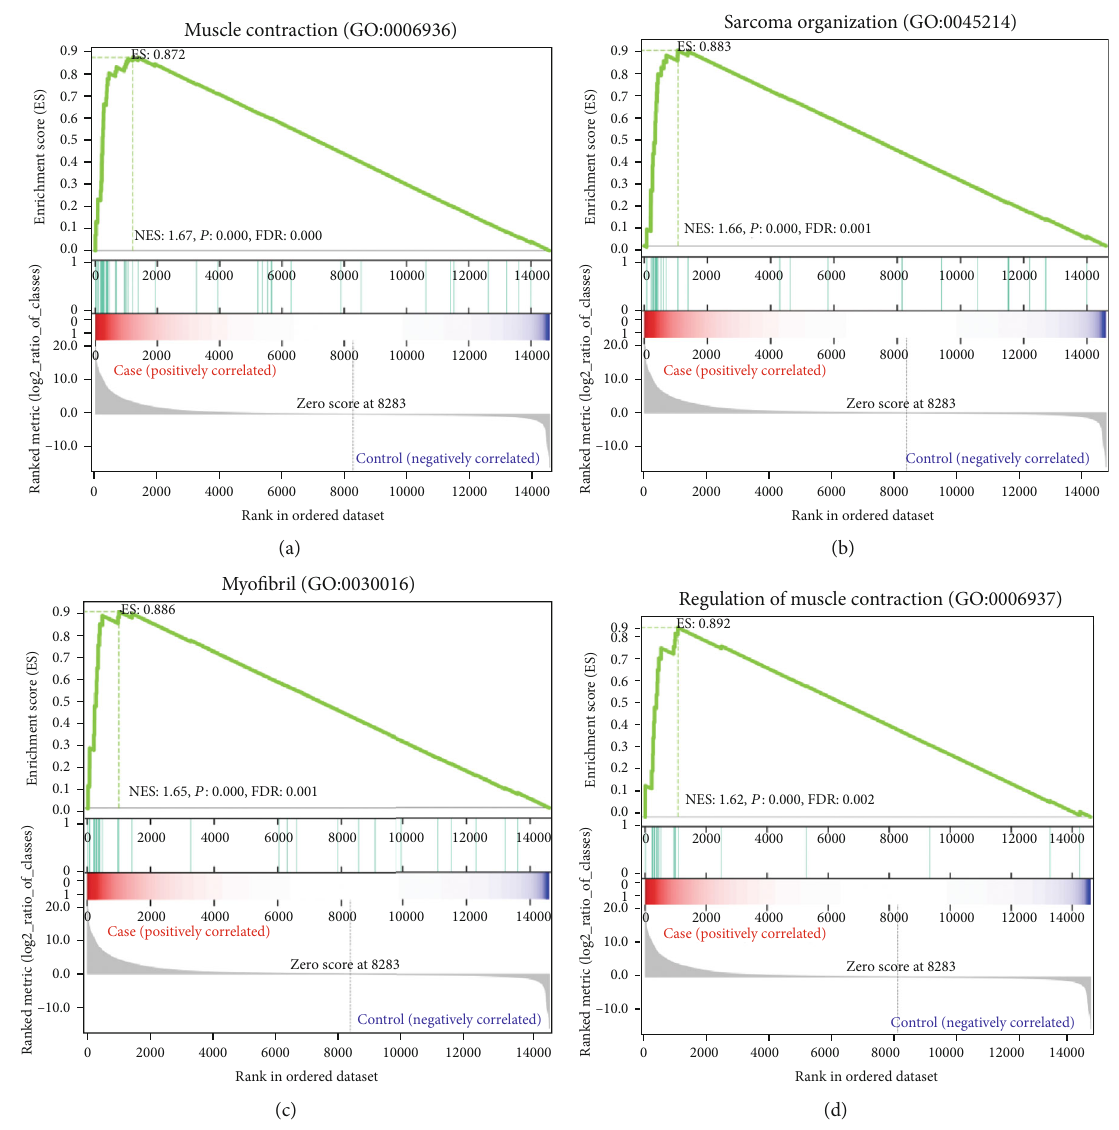
Figure 9: Four GO enrichment graphs of GSEA results. (a) Muscle contraction ( P = 0 : 00 , FDR = 0 : 00 ); (b) sarcomere organization ( P = 0 : 00 , FDR = 0 : 0007 ); (c) myo fi bril ( P = 0 : 00 , FDR = 0 : 0005 ); (d) regulation of muscle contraction ( P = 0 : 00 , FDR = 0 : 0023